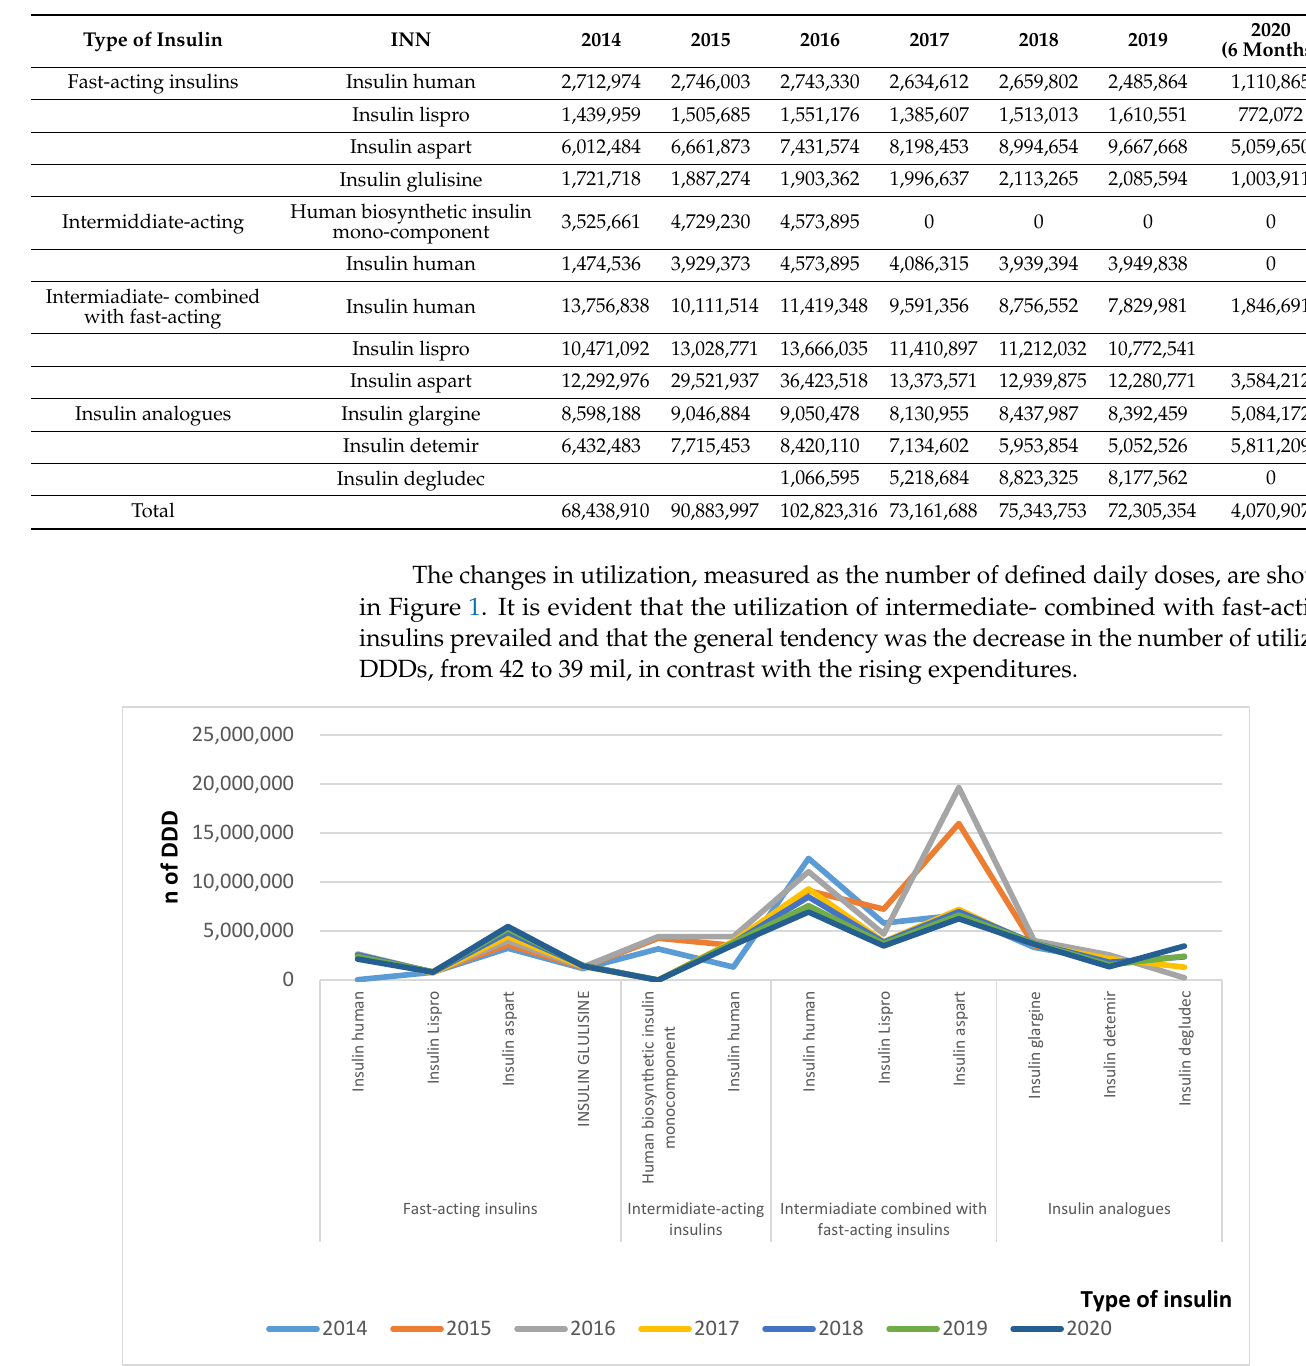
Table 3. Expenditures paid by the NHIF for insulins during 2014–2020 (BGN).